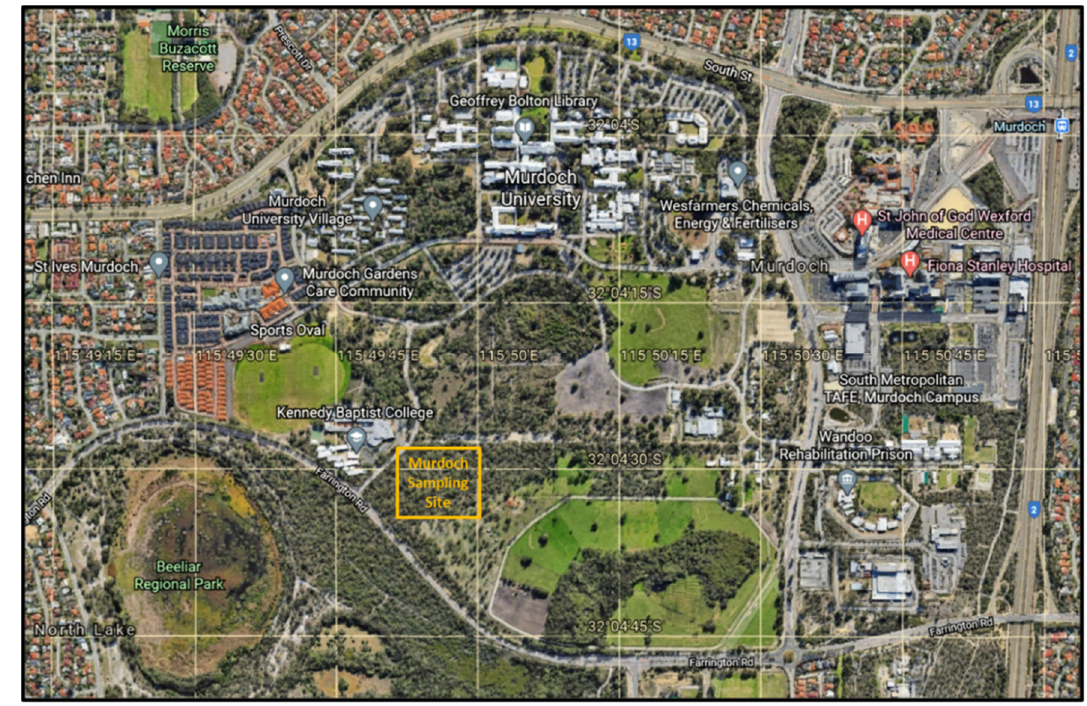
Figure 1. Location of the sampling site at Murdoch University (Source: Google Earth [89]). Figure A1. Location of the sampling site at Murdoch University (Source: Google Earth